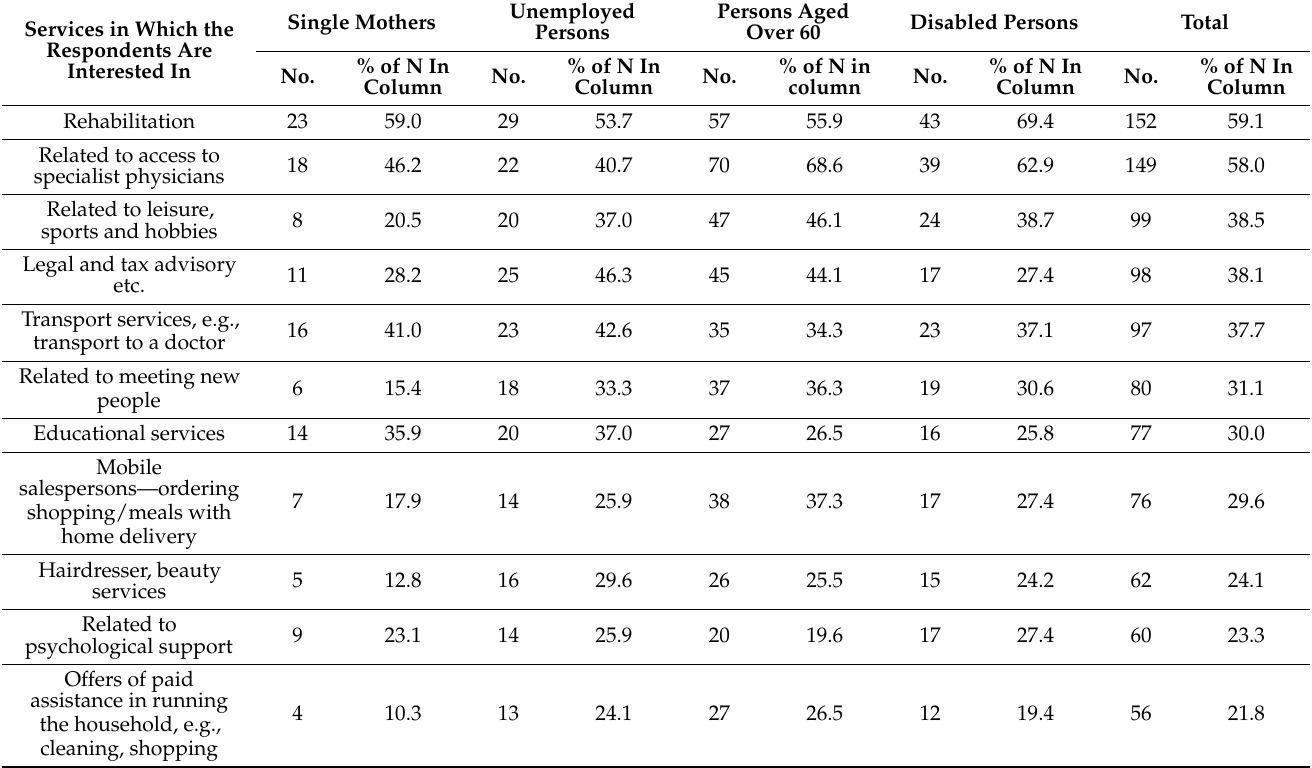
Table 13. Interest in using services available as part of the portal addressed to seniors and persons with disabilities, by social status of the respondents ( n =